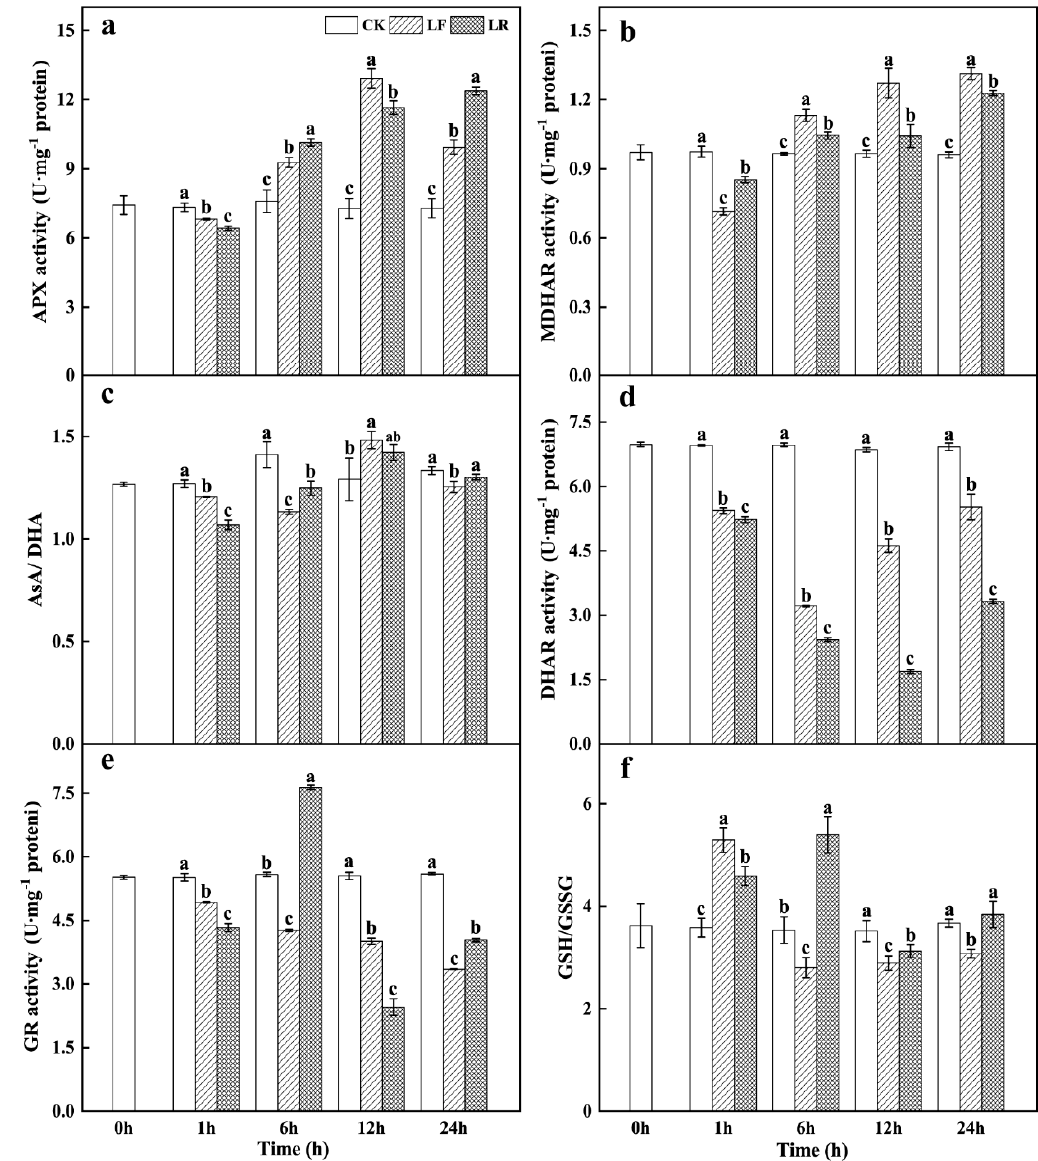
Figure 5. Effects of leaf removal on APX ( a ), MDHAR ( b ), AsA/DHA ratio ( c ), DHAR ( d ), GR ( e ), and GSH/GSSG ratio ( f ) in the roots of M. baccata under suboptimal low root–zone temperatures. Data are means ( ± SE) for three replicates per treatment at each time point independently. Different letters on the bars indicate significant differences between treatments.